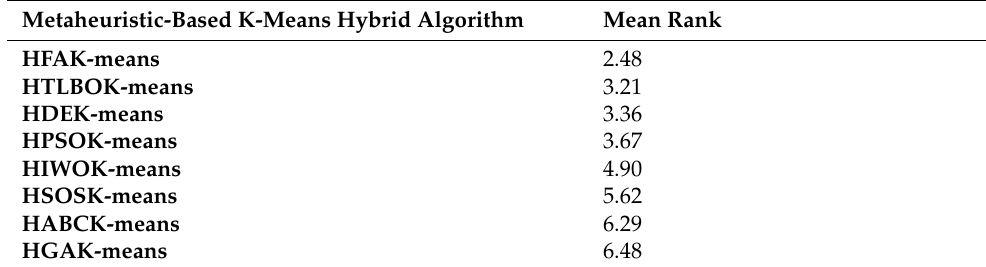
Table 4. Friedman mean rank for the eight metaheuristic-based K-mean hybrid algorithms. Metaheuristic-Based K-Means Hybrid Algorithm